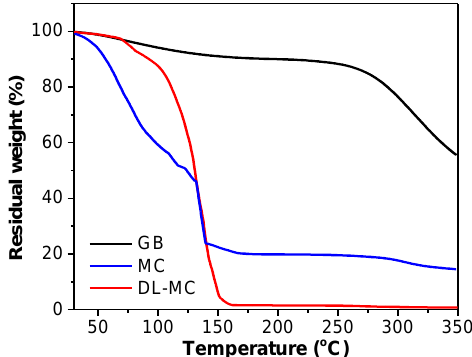
Figure 7. Thermogravimetric analysis (TGA) of GB, MC and DL-MC.